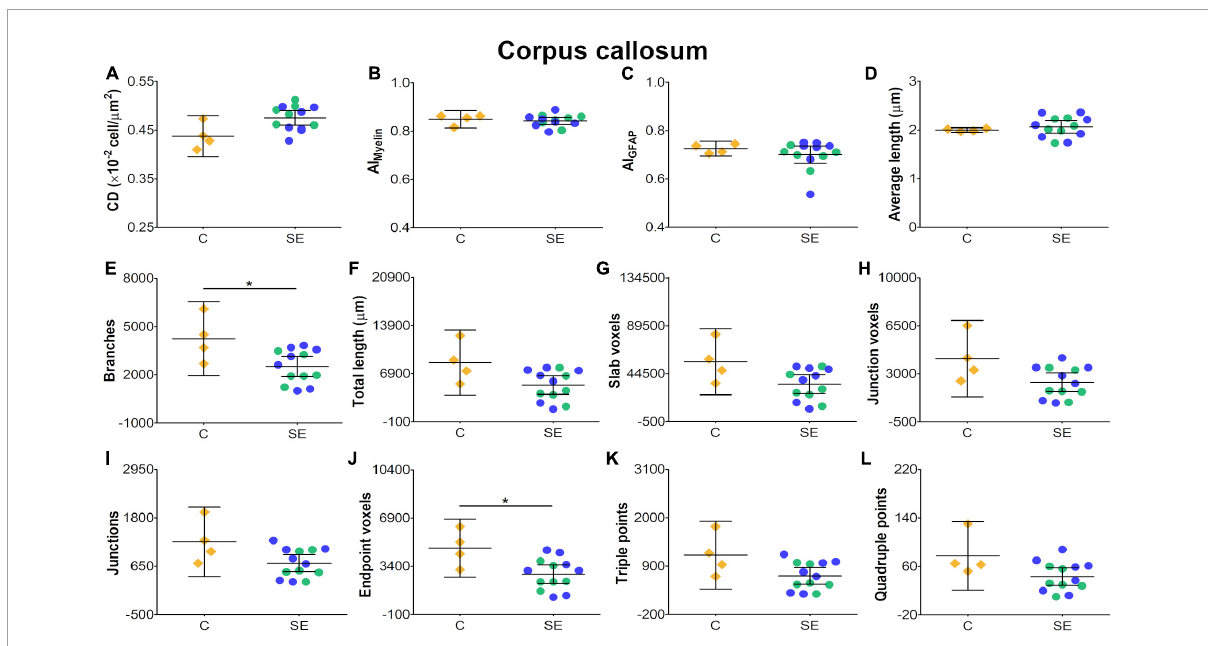
FIGURE4 Histological-derived parameters from automated cell counting analyses (A) , structure tensor (ST)-based analyses of myelin (B) , and ST (C) and skeleton-based analysis (D–L) from GFAP-stained sections in the corpus callosum. Controls are represented as yellow diamonds, kainic acid-treated as green, and pilocarpine-treated as blue circles, respectively. The bars represent the mean values with 95% CI. Differences between C and SE animals are denoted with asterisks (BH-FDR-corrected q -value * < 0.05; two-side permutation t -test). SE animals exhibited decreases in branches (E) and endpoint voxels (J) parameters as compared to controls. AI, anisotropy index; C, control; CD, cell density; SE, status epilepticus.